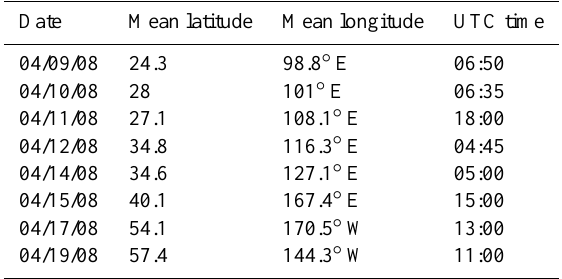
Table 2. Dates, locations and UTC time of each TES profile used during the Thailand wildfire plume